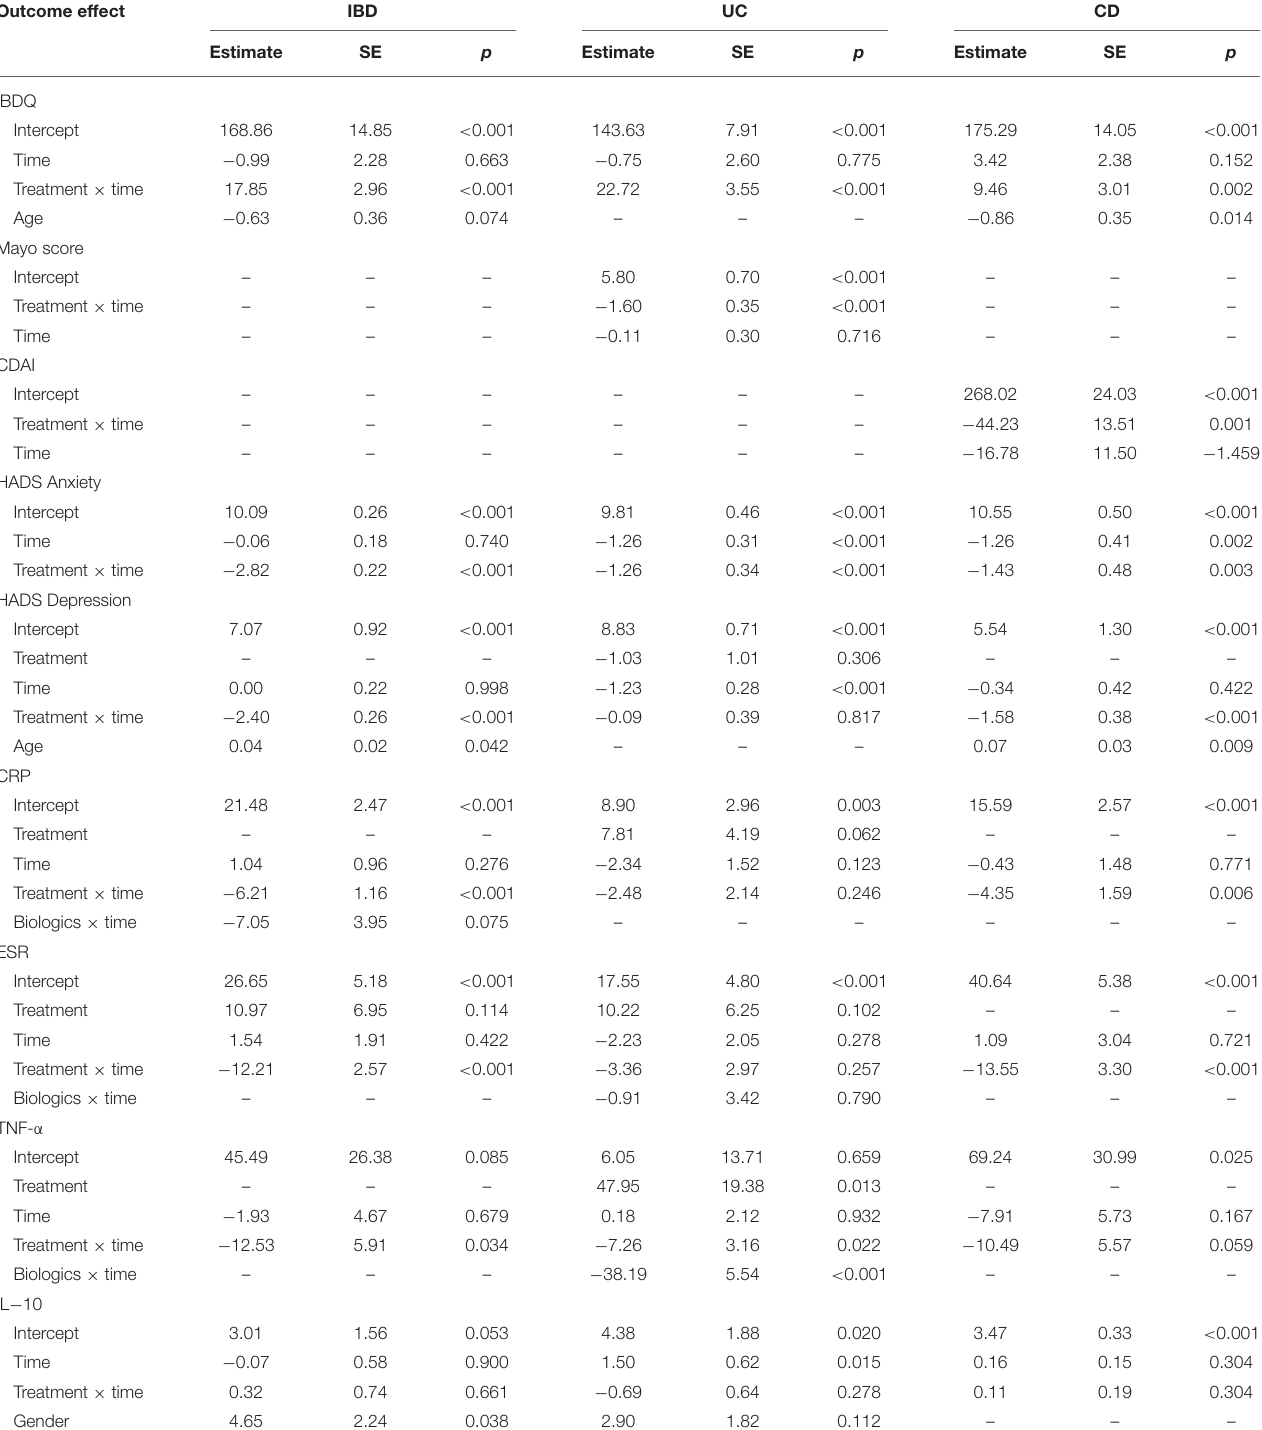
TABLE 1 | The final mixed linear model in inflammatory bowel disease (IBD) population, ulcerative colitis (UC), and Crohn’s disease (CD) subgroups. Outcome effect